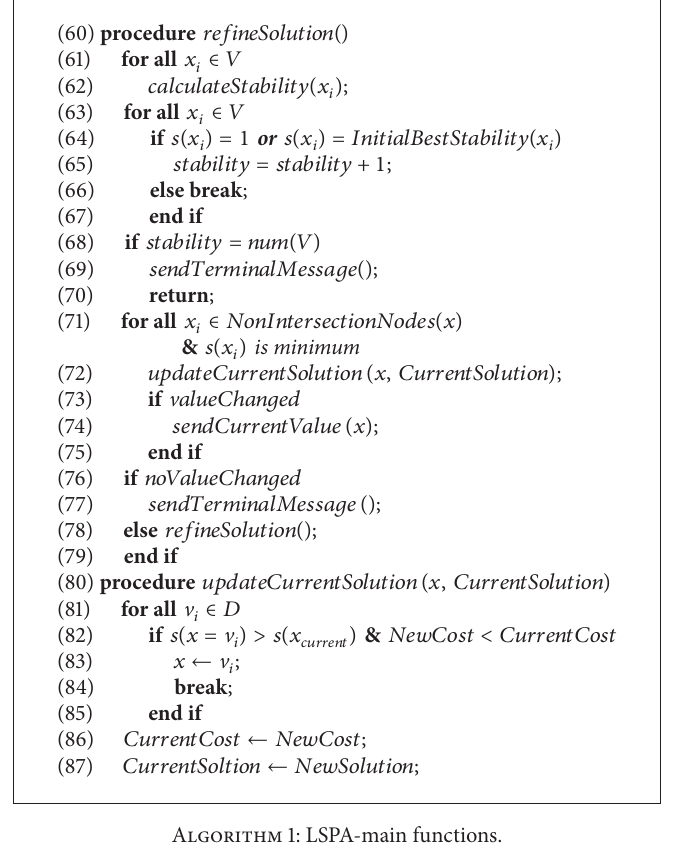
Algorithm 1: LSPA-main functions.